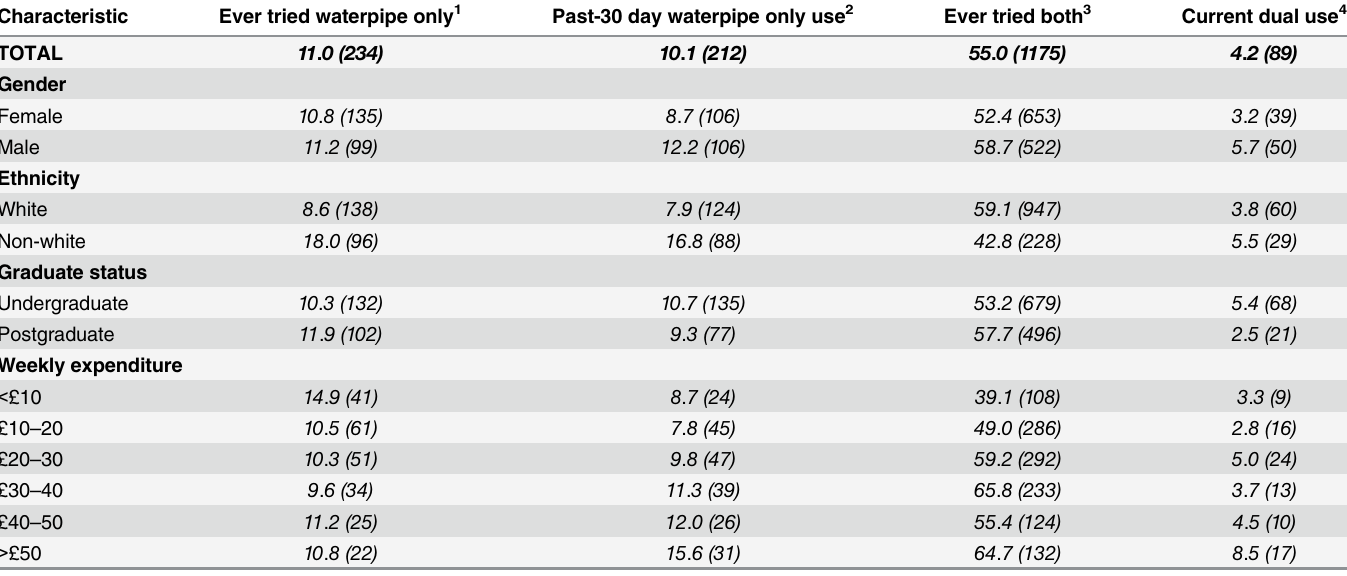
Table 2. Prevalence of waterpipe tobacco smoking by characteristics, % (n).